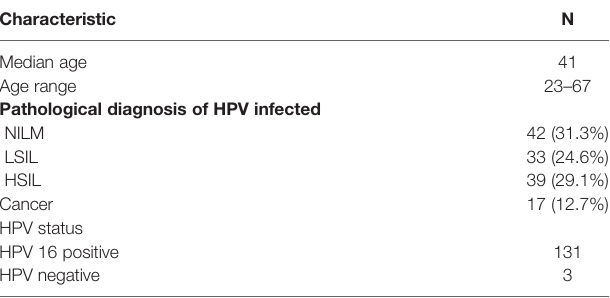
TABLE 1 | Clinical characteristics of enrolled patients at study entry (n =